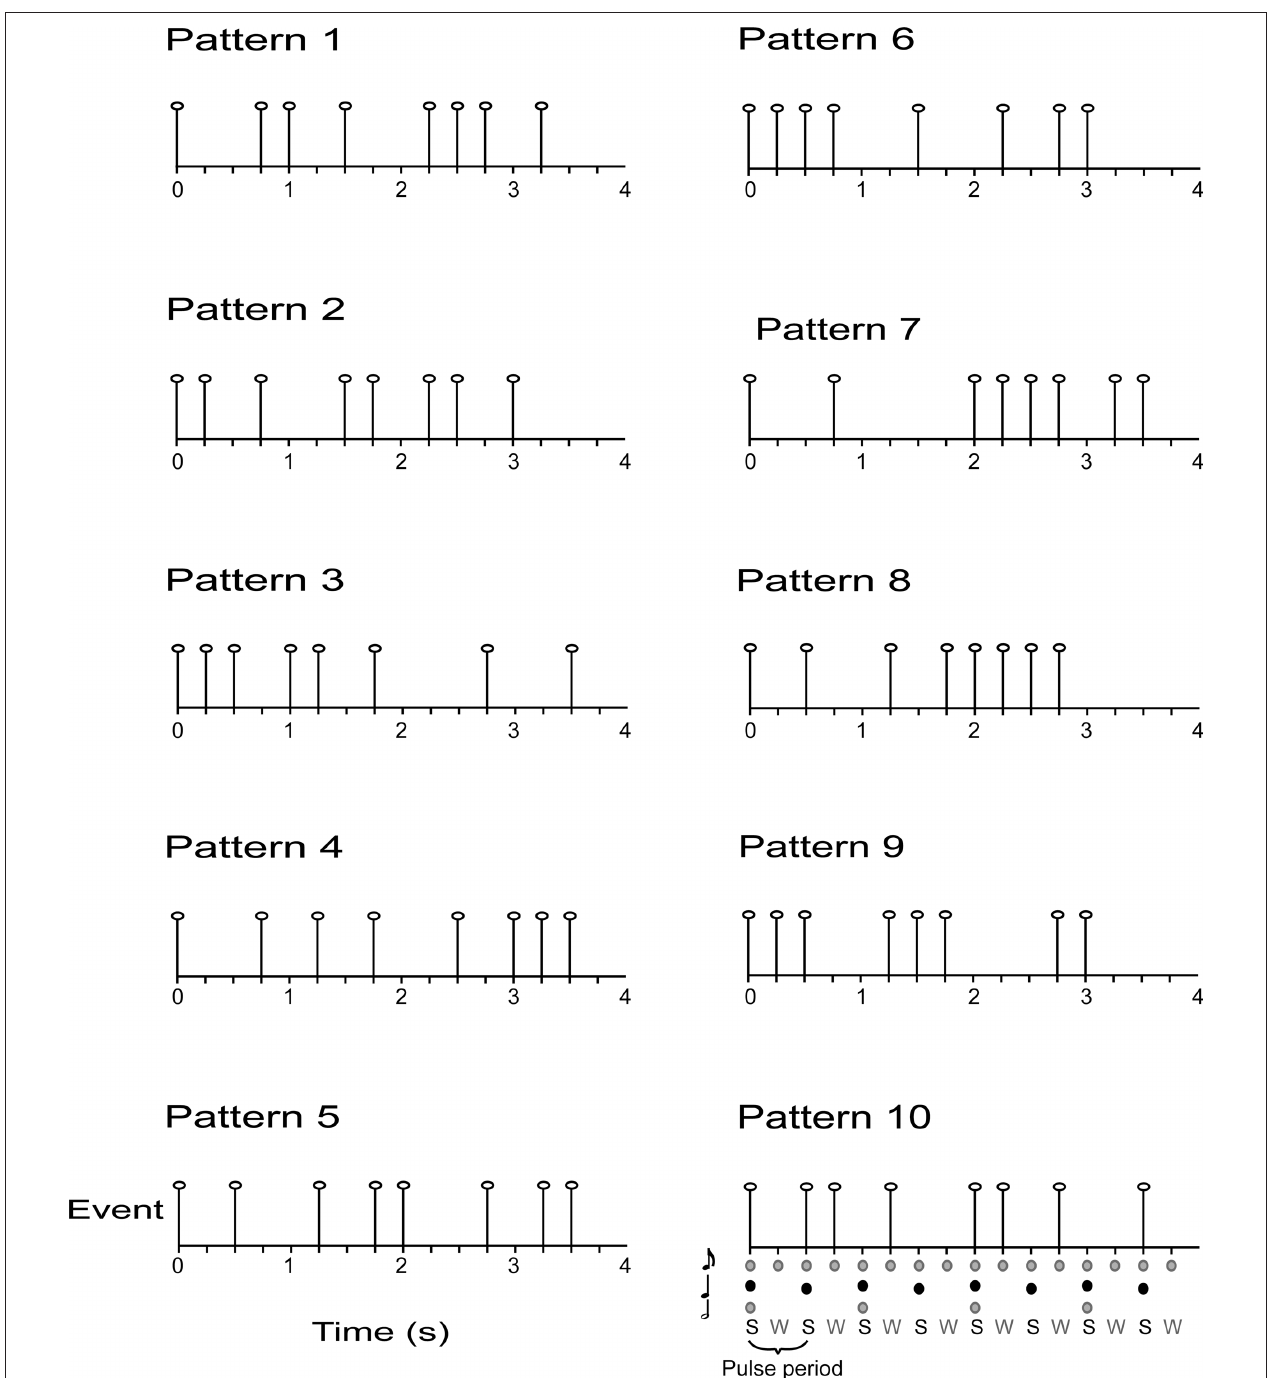
FIguRe 2 | Auditory stimuli consisted of 10 syncopated rhythms with eight acoustic events, each placed at 1 of 16 possible event locations (i.e., eighth-note level beats with an IBI = 250 ms). During the pulse synchronization experiment, participants were asked to tap quarter-note level beats [i.e., the pulse, corresponding to strong beats (S), IBI = 500